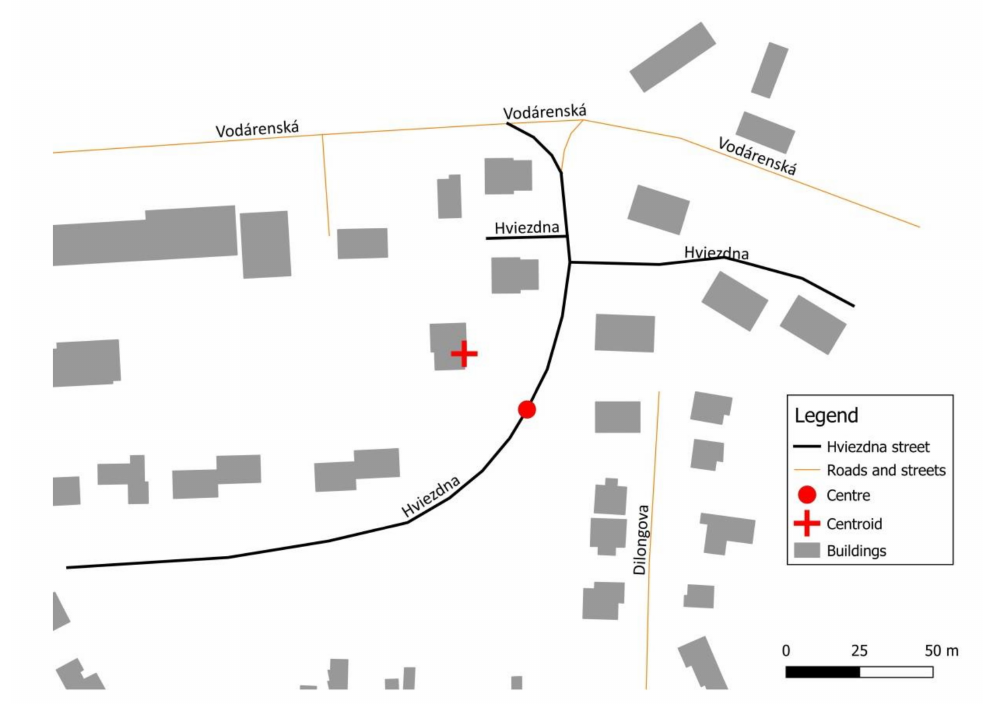
Figure 4. Centroid and center of the Hviezdna